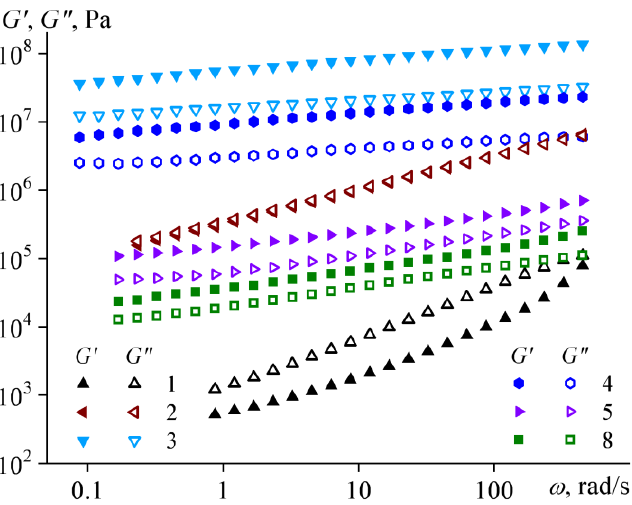
Figure 10. Typical dependences of storage ( G ′ ) and loss ( G ″ ) moduli on angular frequency ( ω ) for bitumens at 25 °C.